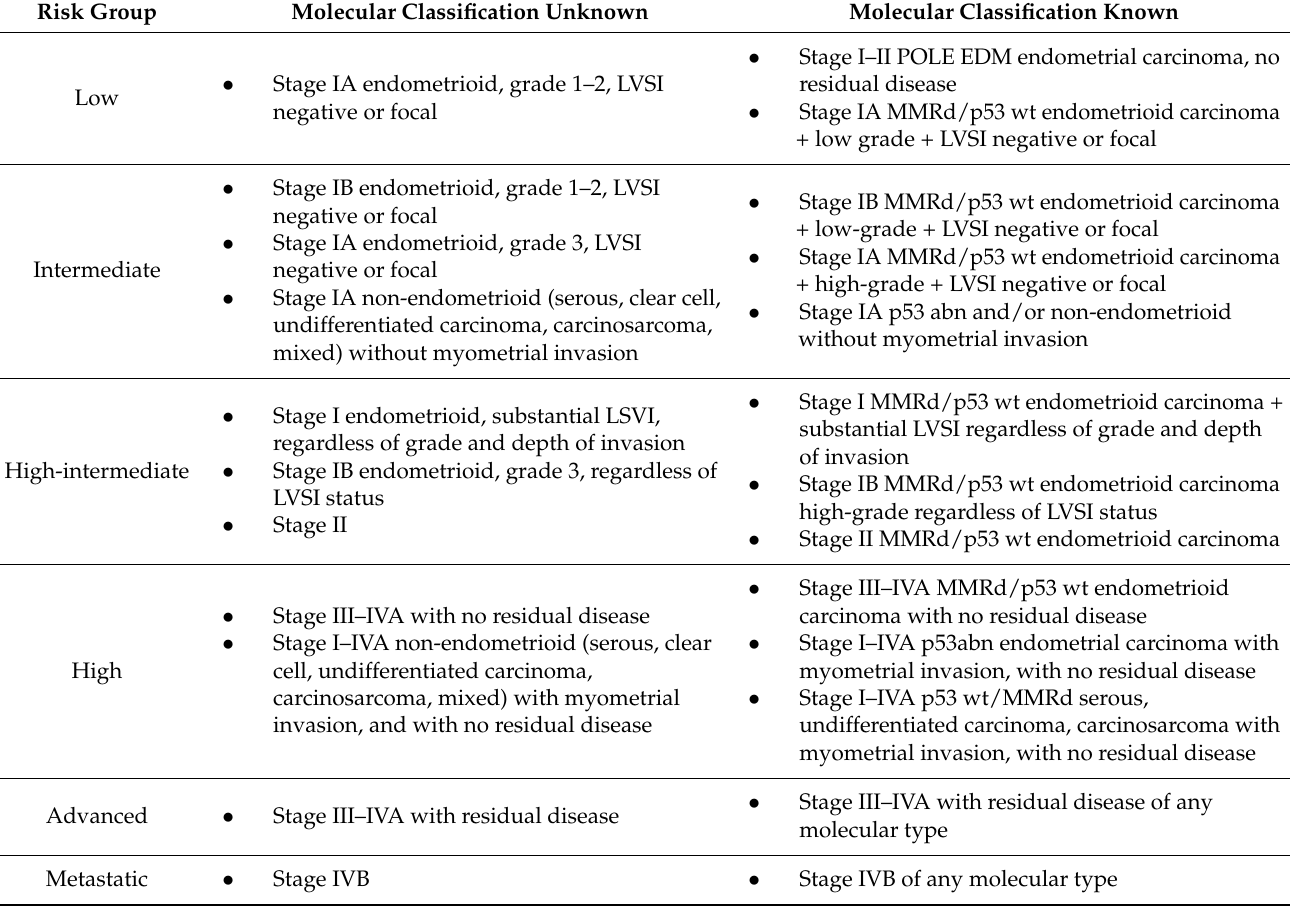
Table 1. 2020 ESGO/ESTRO/ESP prognostic risk group to guide adjuvant therapy use [11].